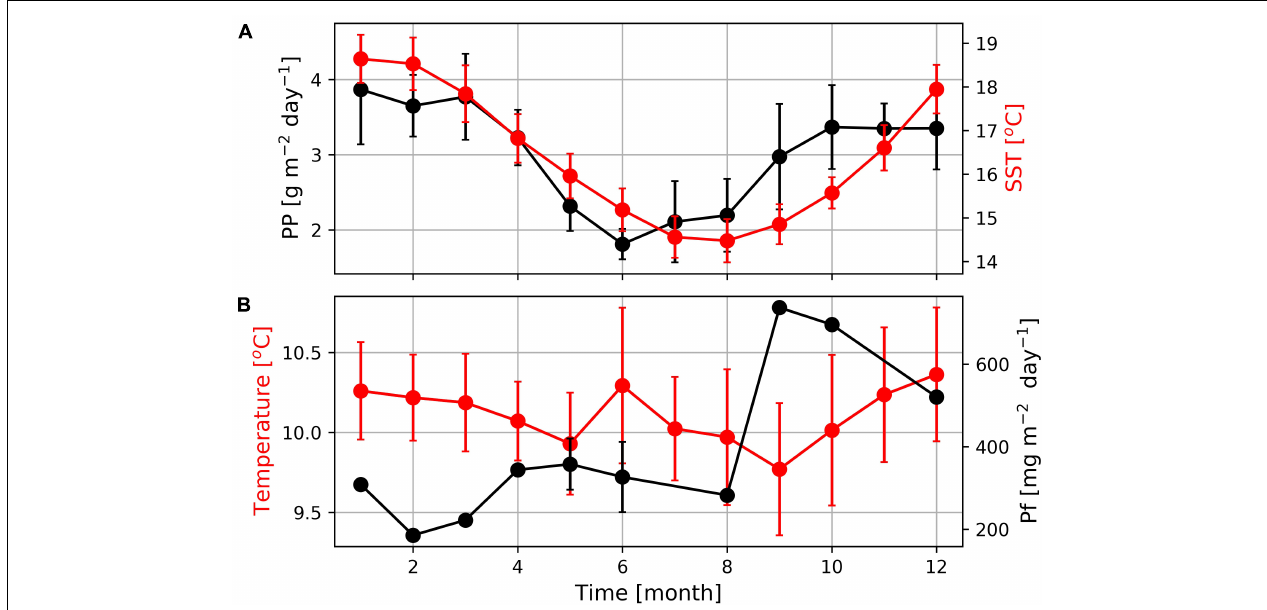
FIGURE 8 | (A) Seasonal variations of primary production (PP) and sea surface temperatures (SST) at the mooring position as well as (B) mean seawater temperature and particle fluxes (PF) measured by the deployed MDO sensor and sediment trap. The absence of error bars indicates that only one data point was available due to long sampling of 40 days.